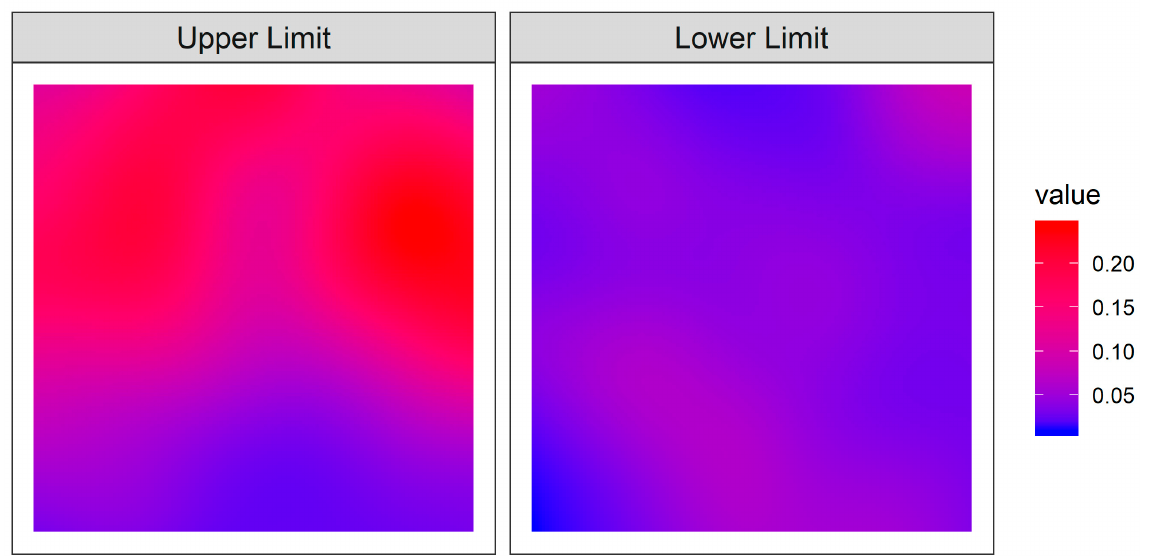
Figure 6. Heatmap of environmental heterogeneity indicated by the density in the sites from the upper and lower limits of the treeline patch.